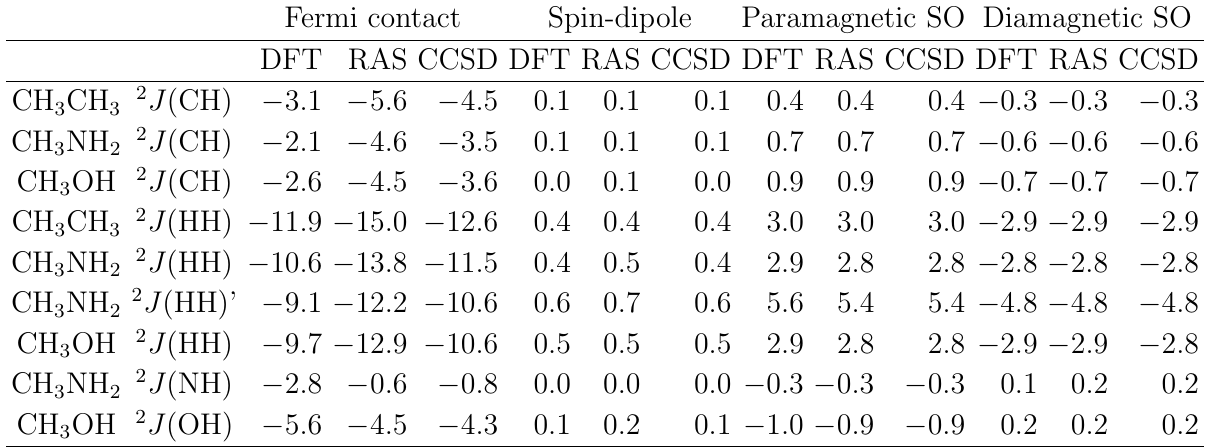
Table 4: Comparison of individual contributions to the geminal coupling constants calculated at the DFT, RASSCF a and CCSD